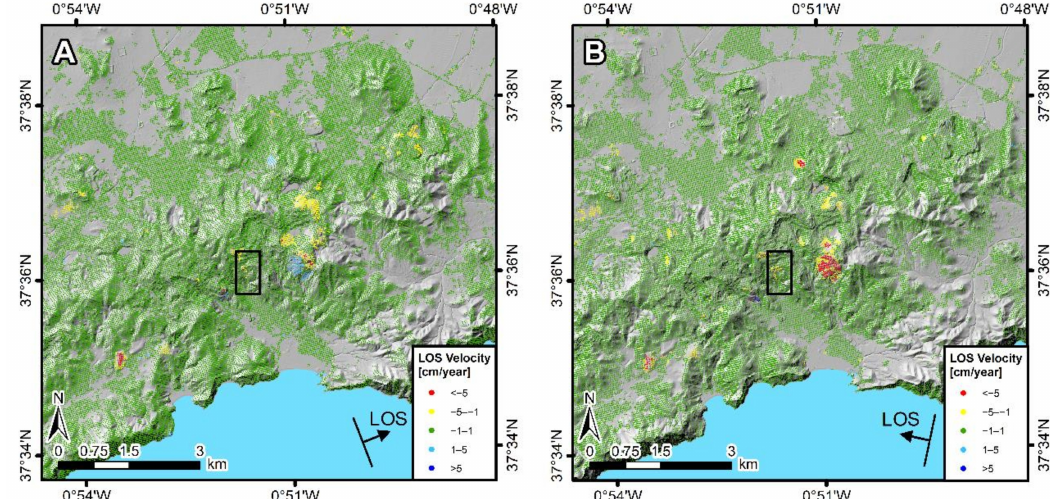
Figure 3. LOS ground velocity maps for the period from 10 July 2017 to 15 November 2018. ( A ) Ascending velocities. ( B ) Descending velocities. The black squares show the location of the slope instability monitored by DGPS and used for the validation